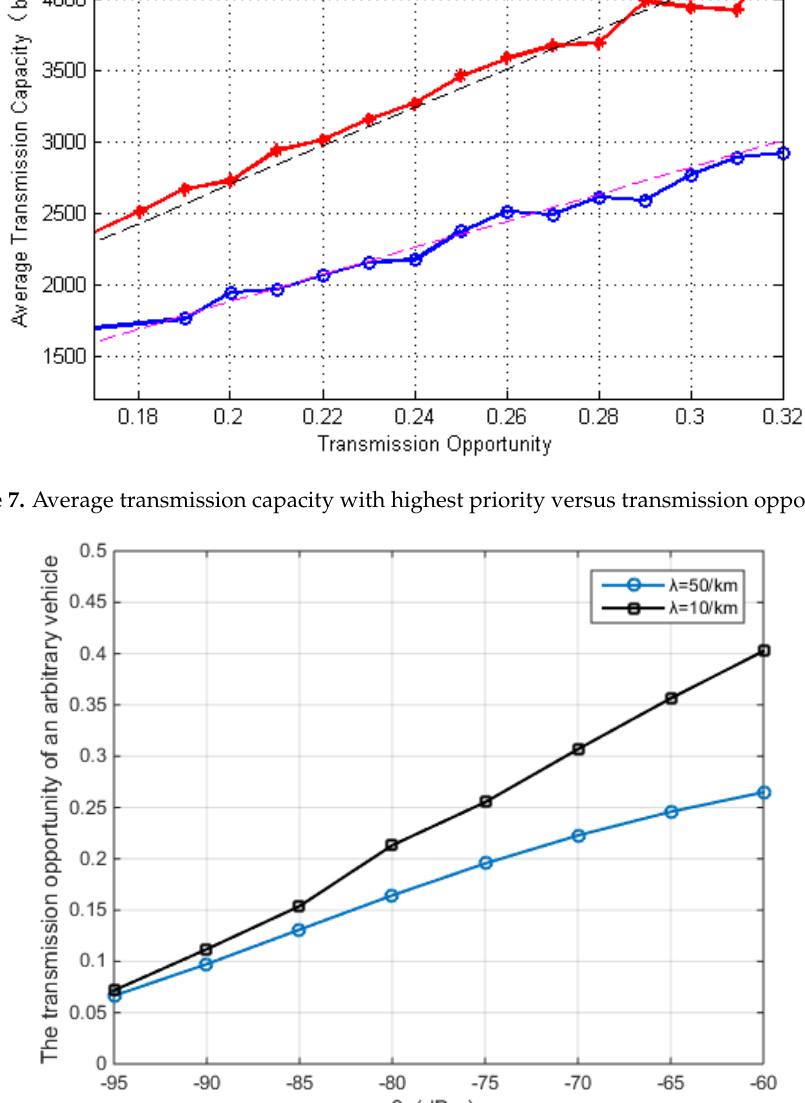
Figure 9. The transmission opportunity with highest priority versus predefined carrier sensing threshold. From Figure 10, the relationship between outage probability and SIR threshold is illustrated, where